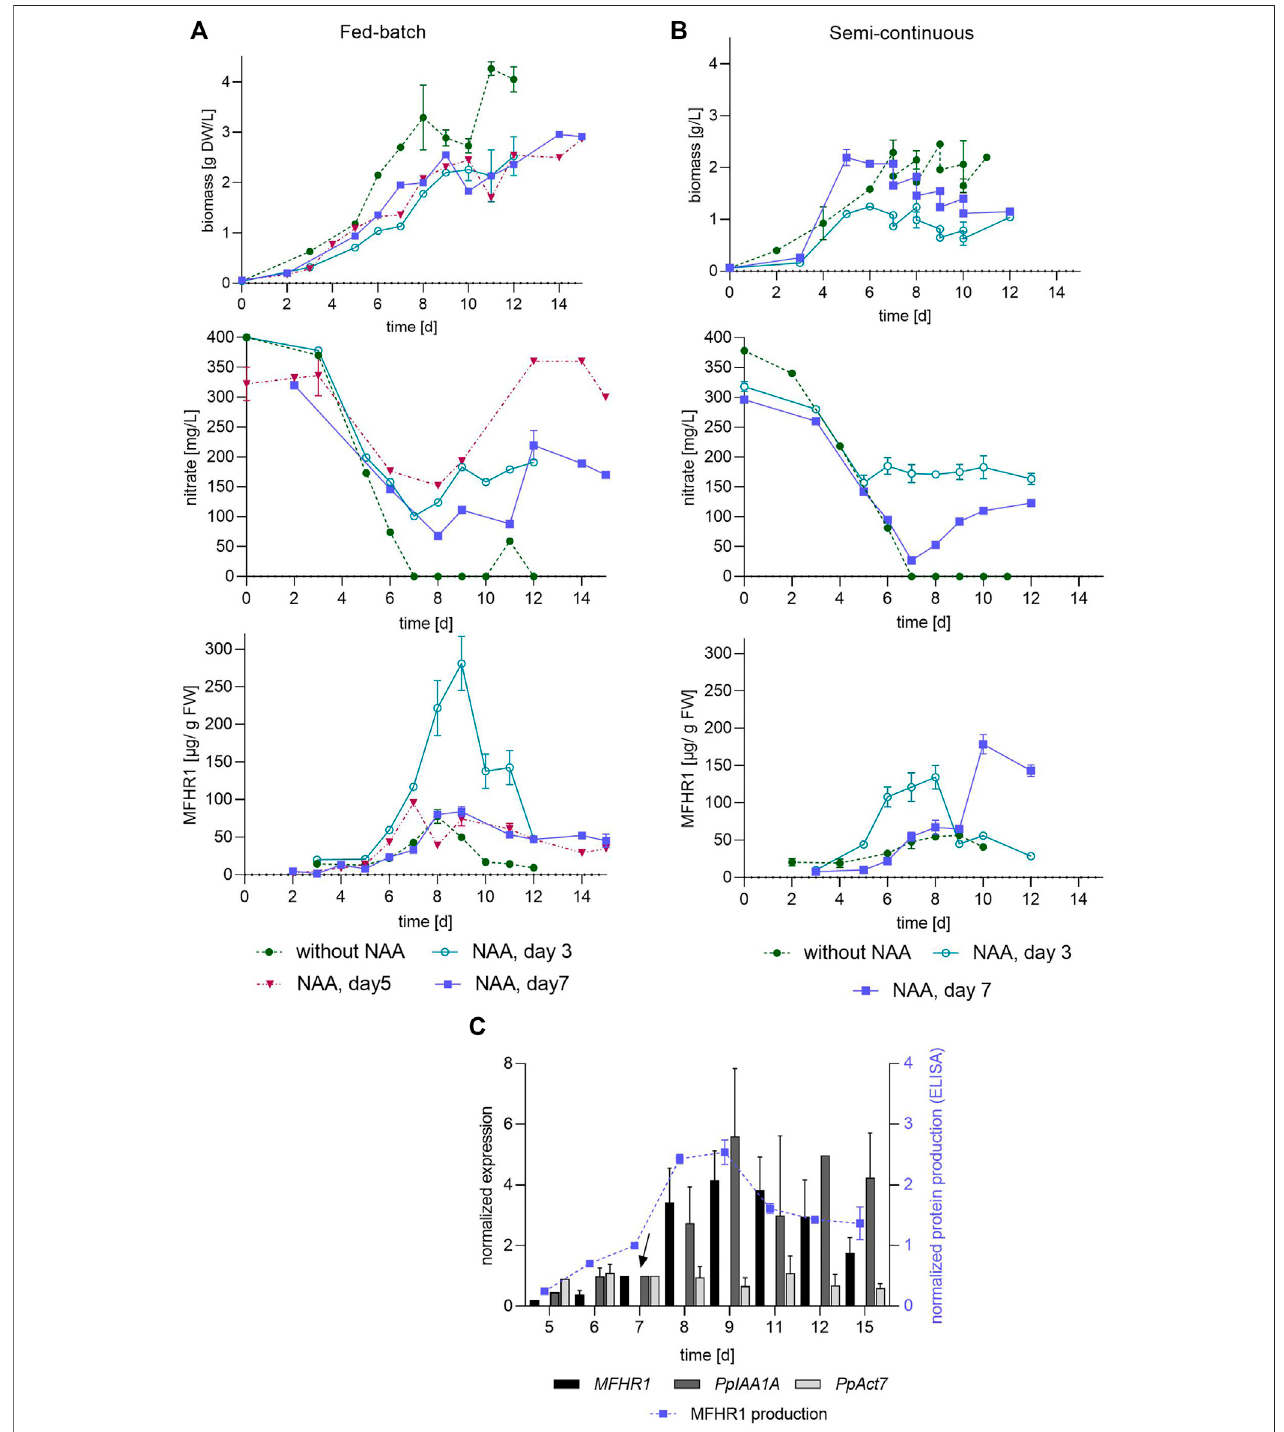
FIGURE 7 | Effect of operation conditions and NAA addition time on recombinant protein production. (A) Fed-batch with and without NAA using transgenic moss line B. (B) Semi-continuous mode with and without NAA using line B. NAA was added at day 3, 5 and 7, respectively. (C) Expression of Aux/IAA gene (ppIAA1A: Pp3c8_14720V1.1), PpAct7 (Pp3c3_33410V3.1) and MFHR1 determined by qRT-PCR of 10 µM NAA-treated bioreactor samples. Data were normalized using two reference genes (coding for EF1- α and 60S ribosomal protein L21) and a point immediately before the addition of NAA (indicated by the arrow) was used as calibrator. A comparison between the protein production measured by ELISA and the expression of mRNA by qRT-PCR is included (data obtained from the bioreactor shown in (A) , NAA added at day 7). Mean ± standard deviations (SD) from three technical replicates are shown.